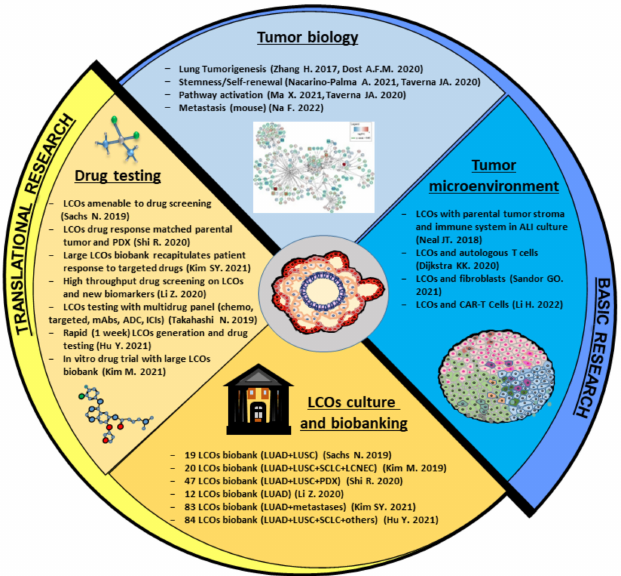
Figure 2. Applications of LCOs in basic and translational lung cancer research. TME, tumor mi- croenvironment; LCOs, lung cancer organoids; ADCs, antibody-drug conjugates; ICIs, immune checkpoint inhibitors; ALI, air–liquid interface; LUAD, lung adenocarcinoma; LUSC, lung squamous cell carcinoma; PDX, patient-derived xenograft. Others: adenoid cystic carcinoma,